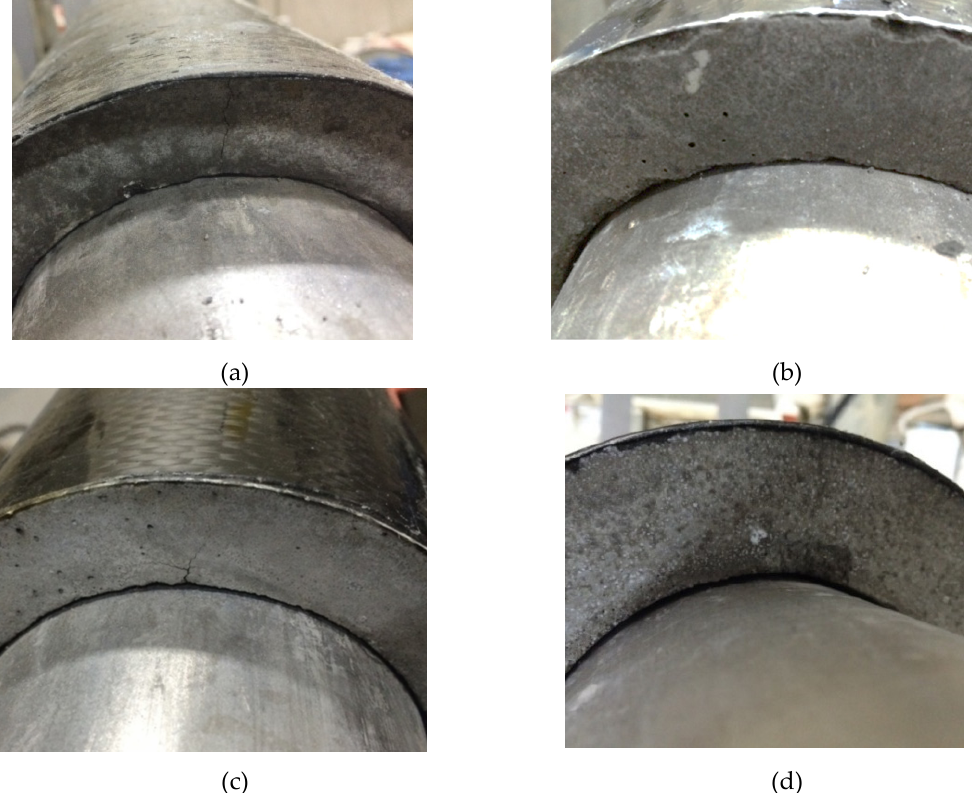
Figure 12. Few hairline cracks were detected in the C-shaped insulation materials after heating. ( a )